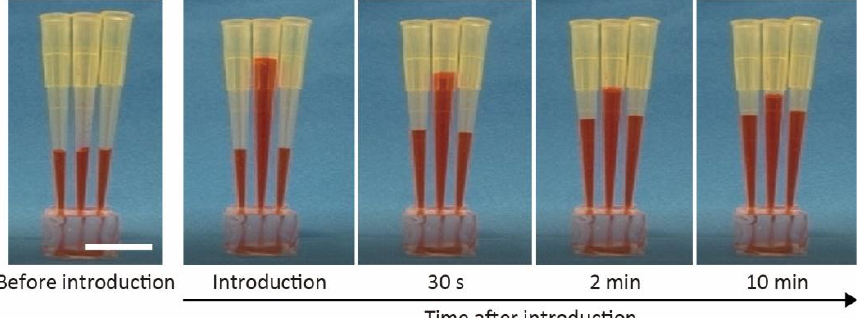
Figure 3. Time-lapse images of introducing water containing red ink into the microchannel from an inlet. Scale bar is 1 cm.